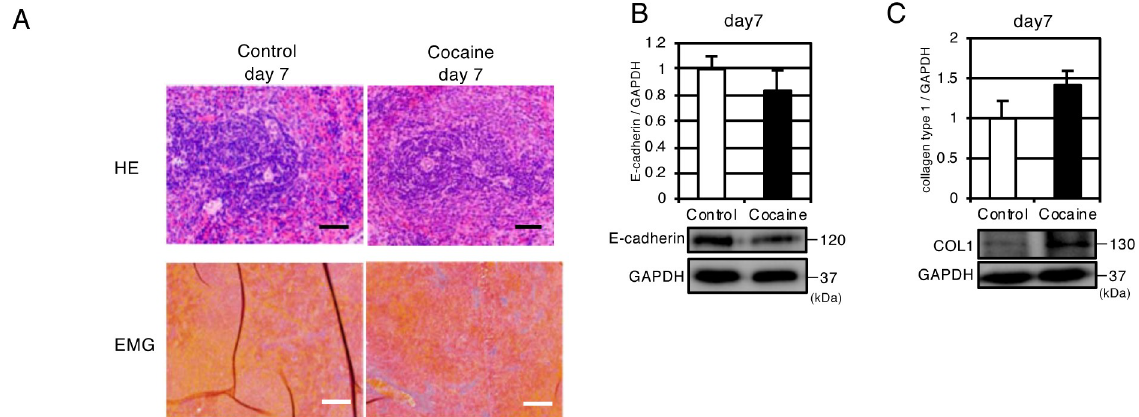
Fig 2. Histochemical and immunoblot analysis of spleen from rats repeatedly administered cocaine (day 7). (A) Hematoxylin and eosin (H&E) and Elastica Masson-Goldner (EMG) staining of spleen. Black and white bars indicate 50 μ m and 100 μ m, respectively. (B-C) Immunoblot analysis of E-cadherin (B) and collagen type 1 (C). GAPDH levels served as the internal control. Graphs show the means and S. D. of 6 samples. � P < 0.05 versus control by Student’s t-test.